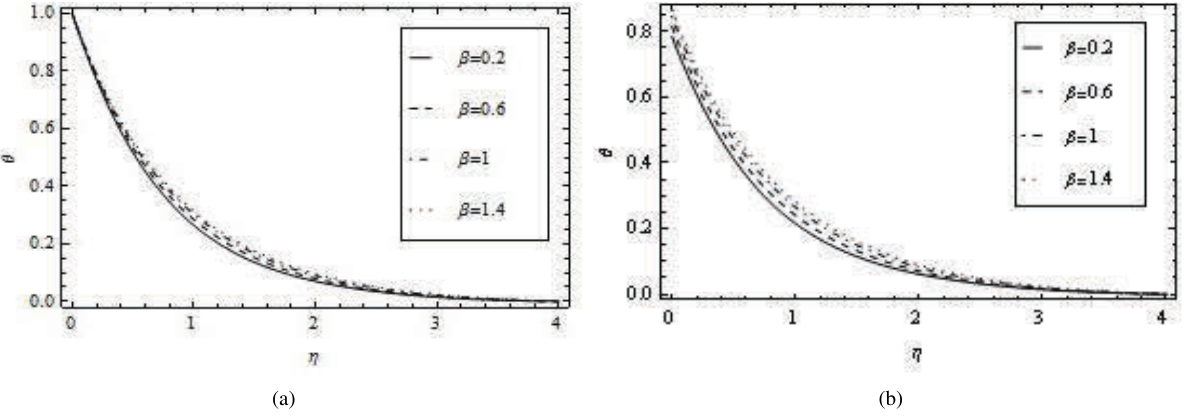
Figure 3. The effect of couple stress parameter ˇ on Temperature when n D 0:25; E c D 0:5; (cid:21) 1 D (cid:21) 2 D 0:5; P r D 1 and k D 1 (a) for PST and (b) PHF